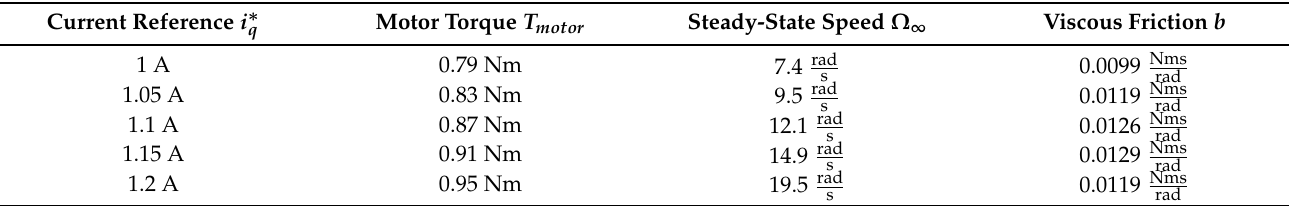
Table 4. Viscous friction coefficient